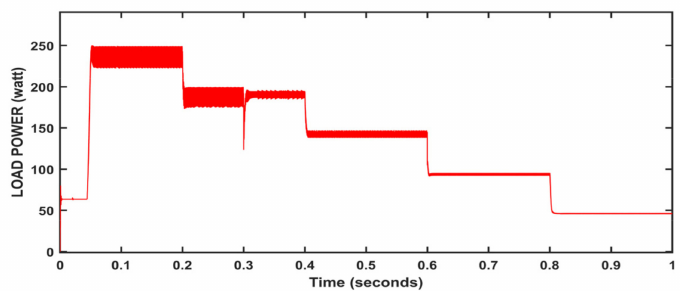
Figure 23. Algorithm performance under variable irradiations and varying loads.